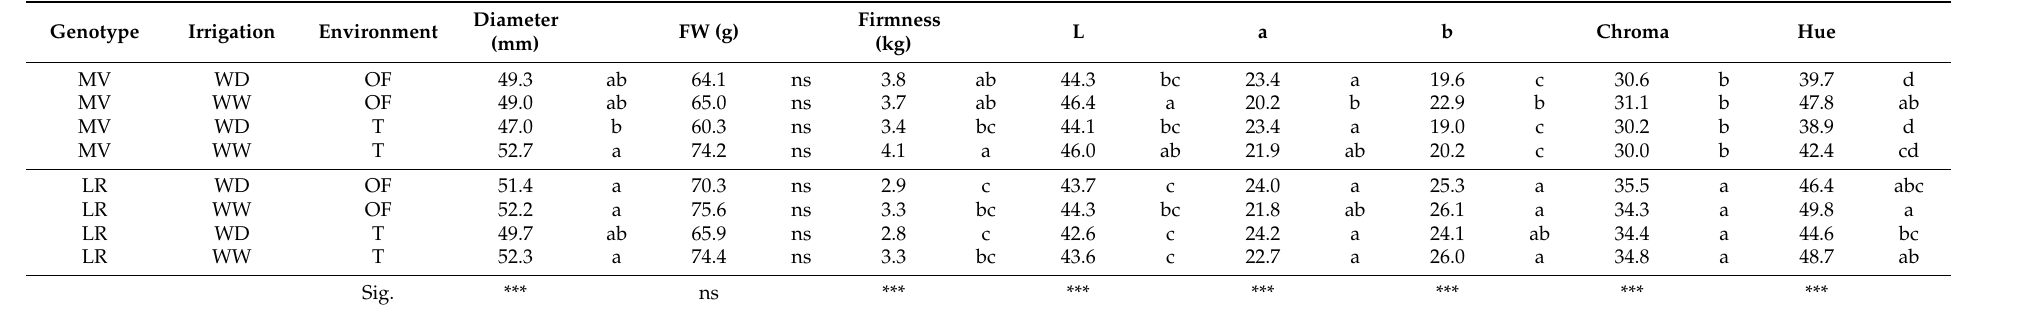
Table 1. Effect of water regime (water deficit, WD; well-watered, WW) and growing environment (open field, OF; tunnel, T) on fruit’s physical characteristics of two Penjar genotypes (landrace, LR; modern cultivar, MV) at harvest. Within columns, data indicated with different letters are significantly different ( p < 0.05). Significance of the ANOVA for each variable is shown on the bottom line (significance levels: * <0.05, ** <0.01, *** <0.001, ns = not significant). Genotype